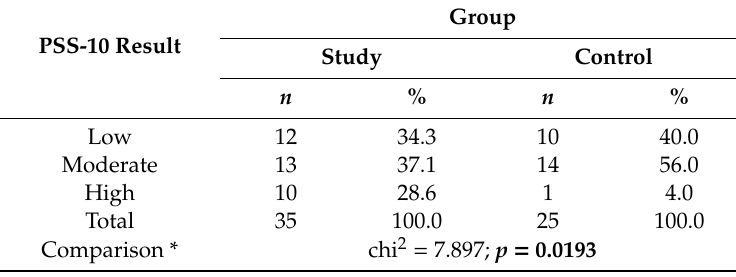
Table 3. Comparison of the frequency of low, moderate and high PSS-10 results in the study and control groups.